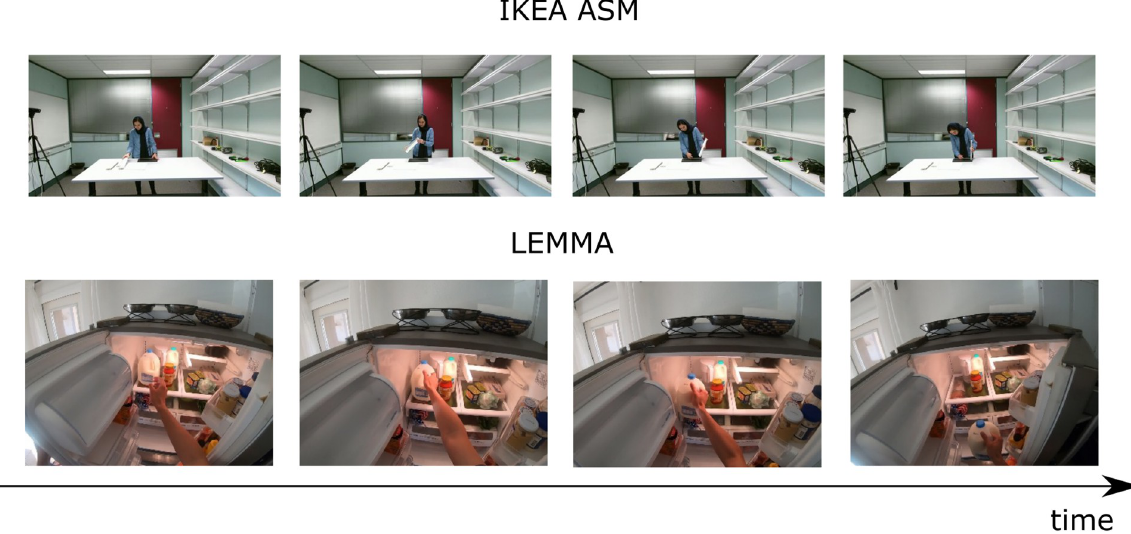
Fig 5. A small sample of compositional action. Red denotes verbs, blue indicates nouns for the interacting objects, yellow denotes location and green denotes tools to be used. If a compositional action consisting of a verb appears in the training set, then that compositional action cannot appear in the testing set. In a word, combinations of actions and objects are forced not to overlap between the training and testing sets.